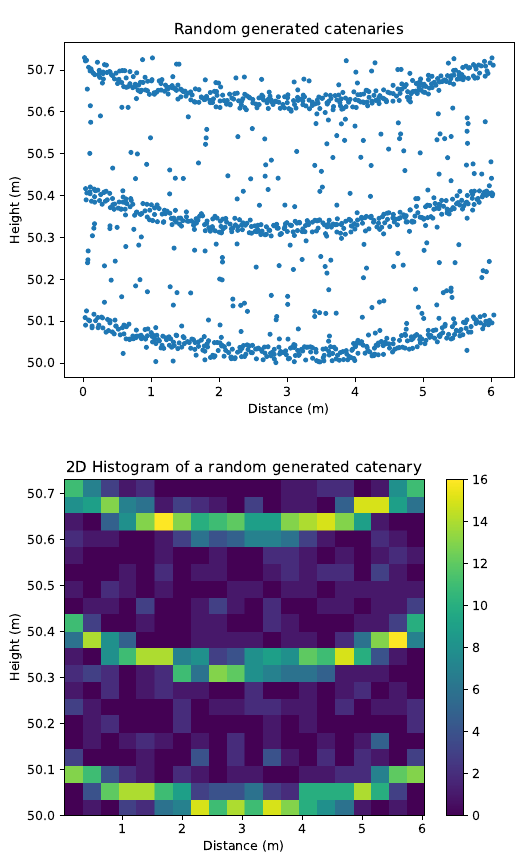
Figure 6. Plot and histogram of a random generated catenary. The colour bar indicates the number of points per bin.